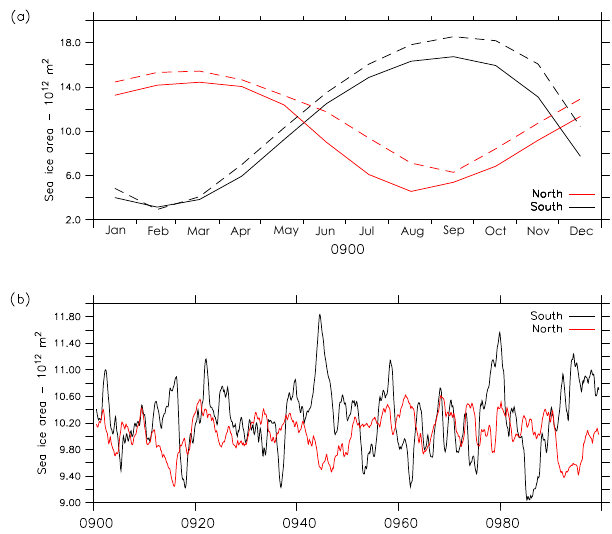
Figure 4. ACCESS-ESM1 simulated (solid) sea-ice are for the Northern (red) and Southern (black) hemispheres from the last 100 years of the pre-industrial simulation for (a) seasonal climatology and (b) annual mean area. Observed seasonal sea-ice area (dashed) is based on Comiso (2000)